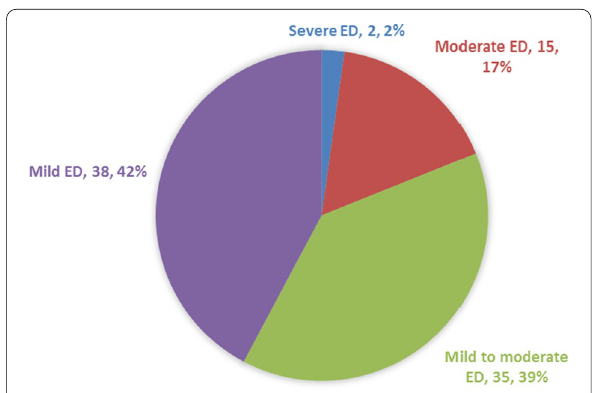
Fig. 2 Frequency distribution of patients with ED